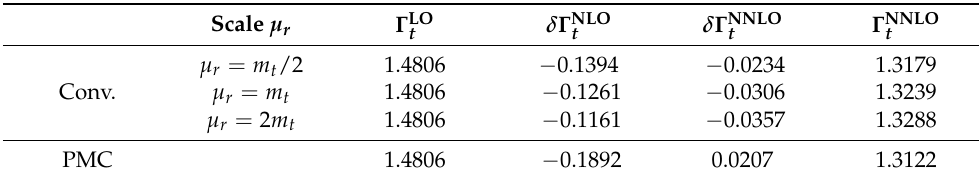
Table 1. Total decay width Γ t up to NNLO QCD corrections (in unit GeV) using the conventional (Conv.) and PMC scale settings, respectively.